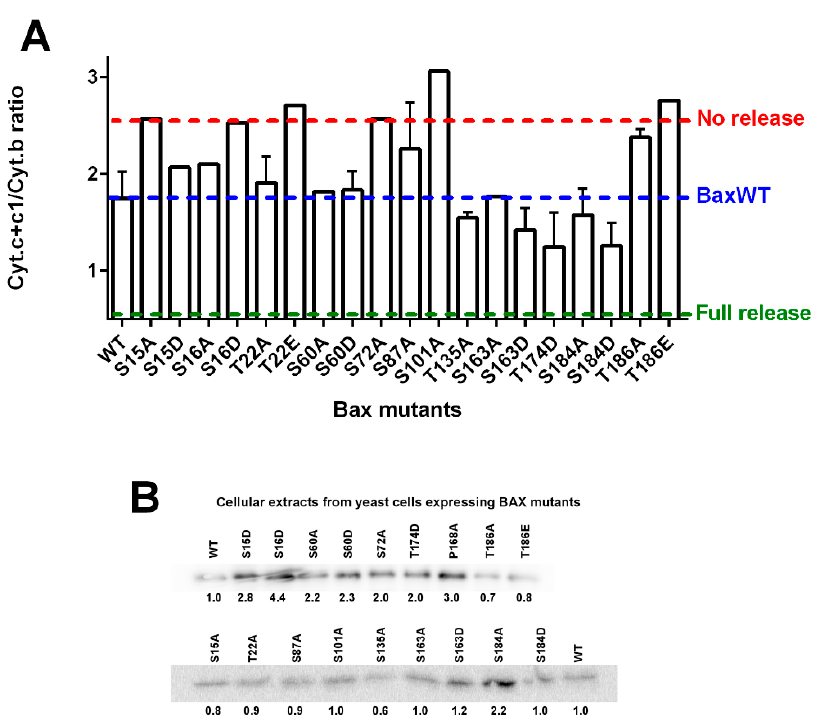
Figure 3. Effect of substitutions of potentially phosphorylatable residues on BAX activity. Different mutants of BAX carrying substitutions of potentially phosphorylatable residues have been expressed in yeast [80]. Potentially phosphorylatable residues were selected based on a mass spectrometry analysis of purified BAX incubated in the presence of AKT or GSK3 β , or known data from the literature. ( A ) After mitochondria isolation, the mitochondrial ratio Cyt.c+c1/Cyt.b was measured by redox spectrophotometry [15]. The blue dashed line indicates the ratio measured on wild-type BAX. The red dashed line indicates the average value measured in W303 yeast strain not expressing BAX. The green dashed line indicated the theoretical ratio value if all cytochrome was released (corresponding to the ratio Cyt.c1/Cyt.b of 0.5 in Respiratory Complex III). Some mutants are significantly more active than wild-type BAX, such as S184D that has been characterized extensively [81,82], but some mutants also appeared to be less active than wild-type BAX. The level of expression of each BAX mutant might be different ( B ), but there is no obvious correlation between the content and the capacity to release cytochrome c: for example, the mutant BAX-S16D (inactive) is expressed at about two-times the level of BAX-WT, the mutant BAX-S135A (moderately active) is expressed at about half the level of BAX-WT and the mutant BAX-S184D (very active) is expressed at about the same level as BAX-WT.